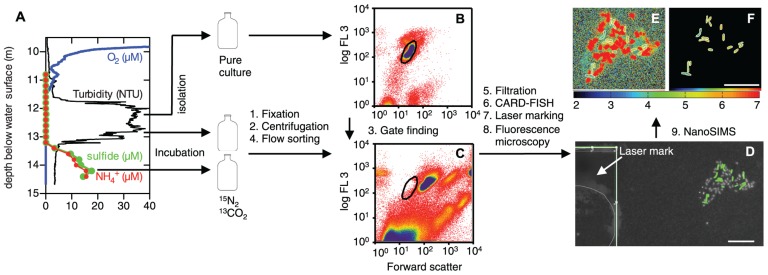
Work flow from sampling to determination of phenotypic heterogeneity with nanometer-scale secondary ion mass spectrometry (NanoSIMS). (A)
In situ profiles of O2 (blue), turbidity (black), sulfide (green), and NH4+ (red) in Lago di Cadagno. The arrows indicate the sampling position for stable isotope incubations with and without NH4+ and isolation of a Chlorobium phaeobacteroides pure culture. After incubations, the samples were fixed with formaldehyde, washed by centrifugation, and subjected to flow cell sorting. (B,C) Flow cytometry plots of the C. phaeobacteroides pure culture (B) and the lake community (C) based on forward scatter (FSC) and auto-fluorescence (FL3; ex.: 488 nm; em.: 664 nm long-pass filter). The sorting gate (black circle) for the lake sample was determined from the pure culture plot. The color gradient from red to yellow to blue indicates increasing count density. Sorted cells that were placed on a membrane filter, hybridized with a CARD-FISH probe targeted against C. phaeobacteroides (green), and stained with Hoechst general DNA stain (gray) as shown in (D). A mark etched with a laser into the membrane filters is shown in the white inset in (D). The etched mark is the thick broken line underneath the thin gray line that digitally marks the drawing position of the laser. The mark is used to find the position of the imaged cells for NanoSIMS measurements. (E,F)
15N atom fractions [12C15N/(12C14N + 12C15N)]⋅10-3 according to the color scale calculated from nitrogen ion counts obtained with NanoSIMS for cells shown in (D). (E) All data and (F) data for cells segmented on the basis of the CARD-FISH signal in (D). Scale bars are 10 μm.